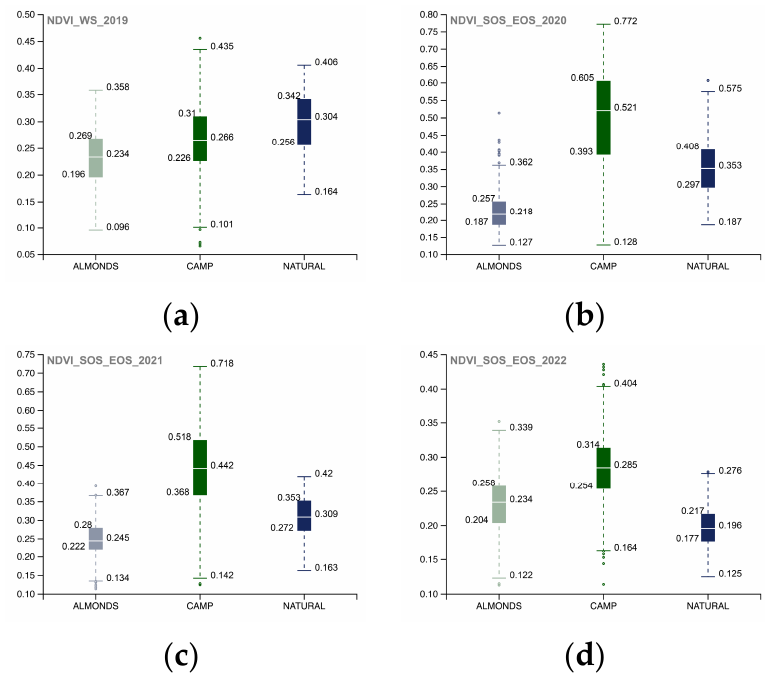
Figure 15. The yearly boxplots summarize NDVI WS quantitative distribution values and compare each portion of the AOI (01_REGENERATIVE_ALMONDS.shp; 02_CAMP_ALTIPLANO.shp; 03_NATURAL_AREA.shp) with five standard statistics: the smallest value, lower quartile, median, upper quartile, and largest value; here the comparison allows for yearly analysis of the cumulated values of each portion of the AOI, specifically (a) 2017, (b) 2018, (c) 2019, (d) 2020. Landscape restoration actions of the Camp_Altiplano achieve an overall coherent trend of vegetation activity during the winter period, tangibly proving the resilience of the ecosystem restoration methodologies.